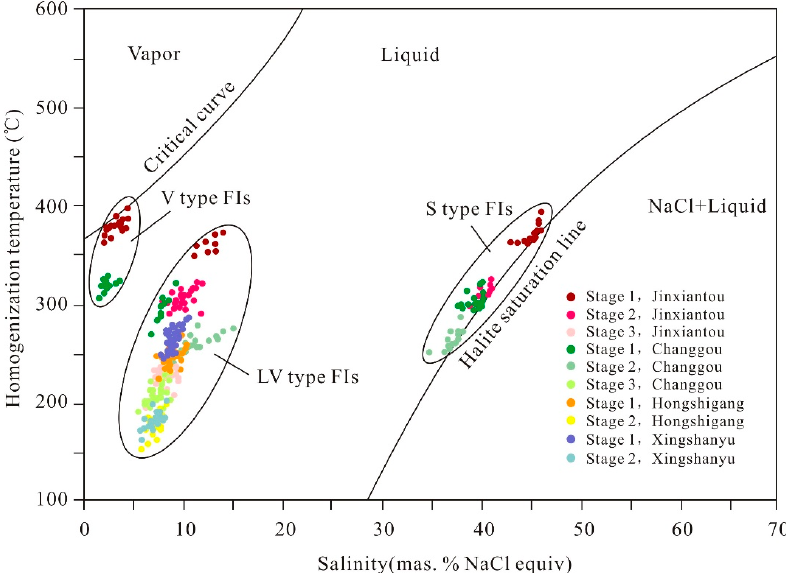
Figure 10. Plot of Th vs. salinity for fluid inclusions in quartz representing the different mineralization stages of the four deposits in the Qibaoshan polymetallic ore field. Minerals 2019 , , x FOR PEER REVIEW